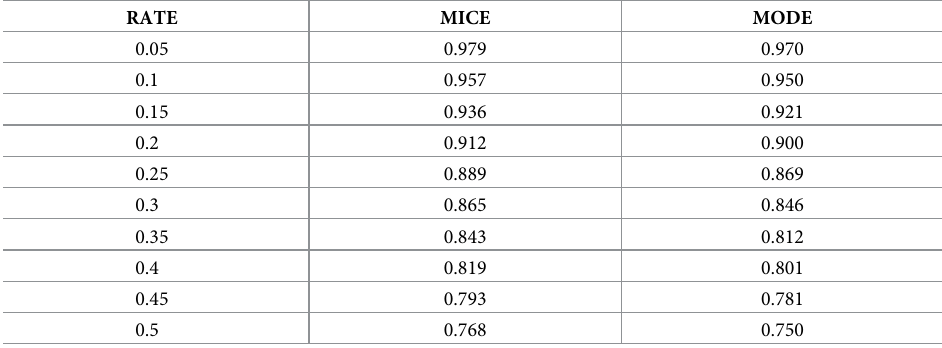
Table 2. The overall accuracy of MICE and